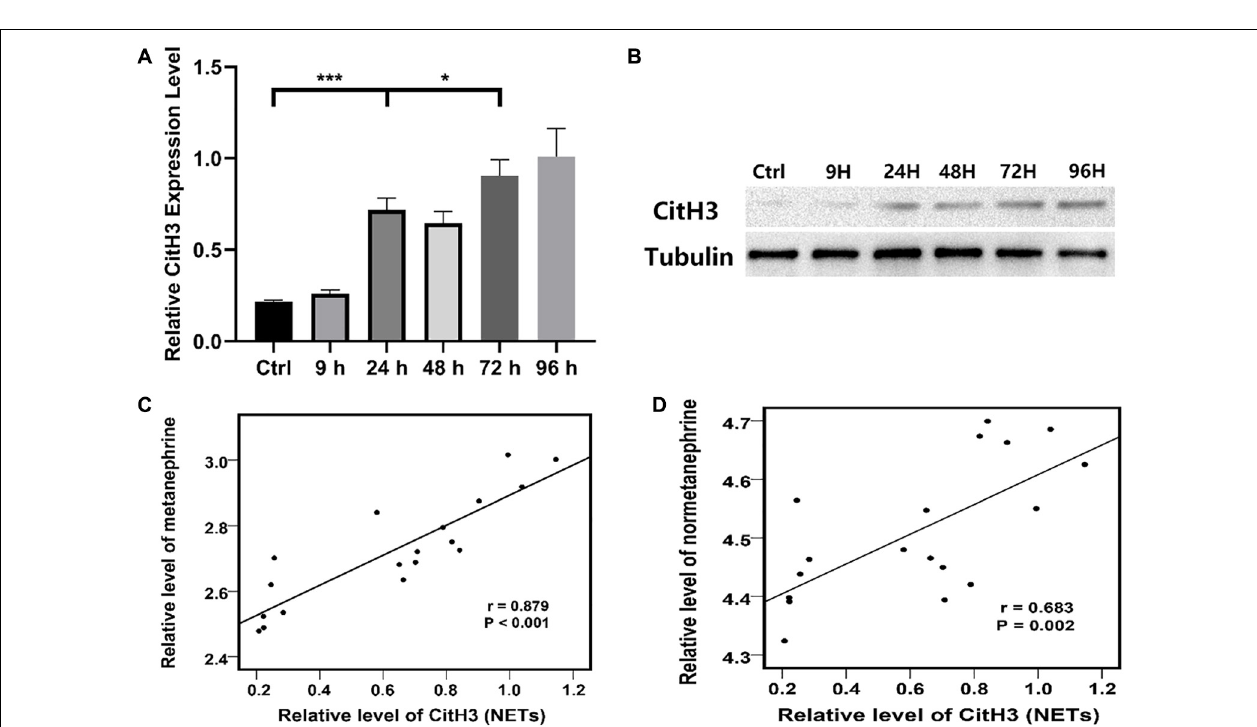
metanephrine was positive correlate to that of CitH3 (NETs) according to Pearson correlational analysis, r = 0.879, P < 0.001. (D) Relative level of normetanephrine was positive correlate to that of CitH3 (NETs) according to Pearson correlational analysis, r = 0.683, P = 0.002. Grouping: DAI group ( n = 18) and sham-injury group ( n =